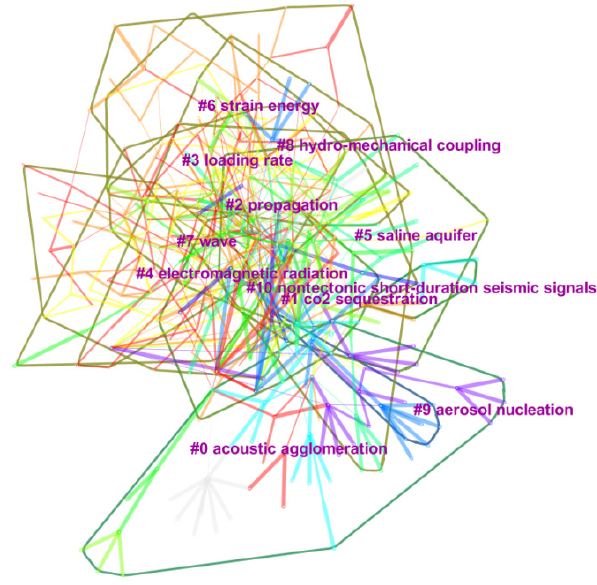
Figure 11. Main clusters in rockburst research of hard rock. Table 4. Keyword clustering